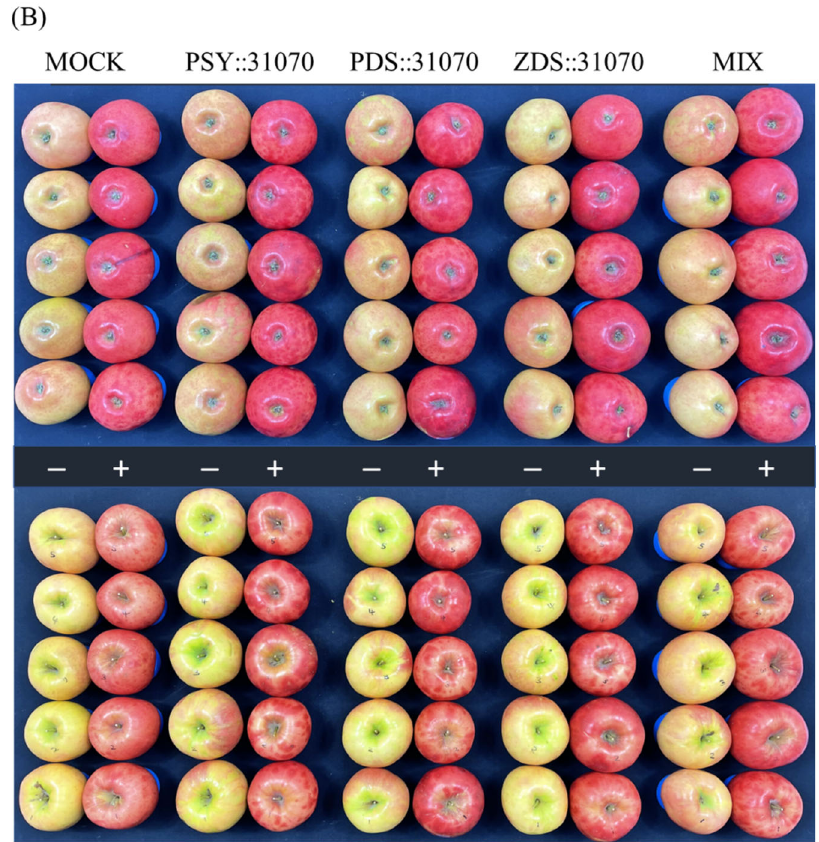
Figure 5. Schematic diagram of expression vectors for three carotenoid biosynthesis-related genes PSY::301070, PDS::31070, and ZDS::31070 ( A ). Apple ‘RubyS’ fruits were Agro-infiltrated with the expression vectors containing the pro-vector parts (5 (cid:48) and 3 (cid:48) ) and the integrase source using a vacuum after seven days of treatment with darkness ( − ) and light exposure (+) ( B